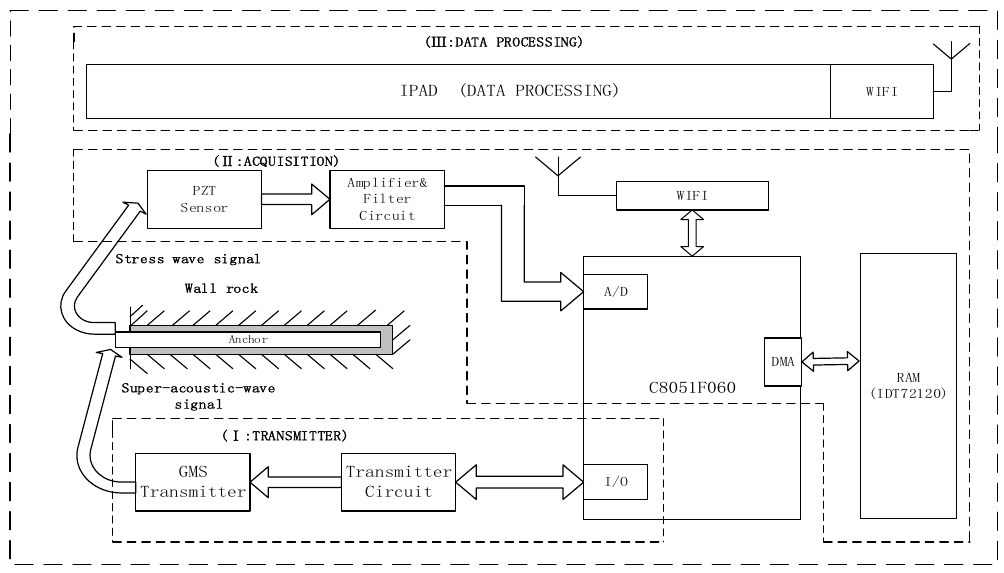
Figure 1. Measurement system setup.